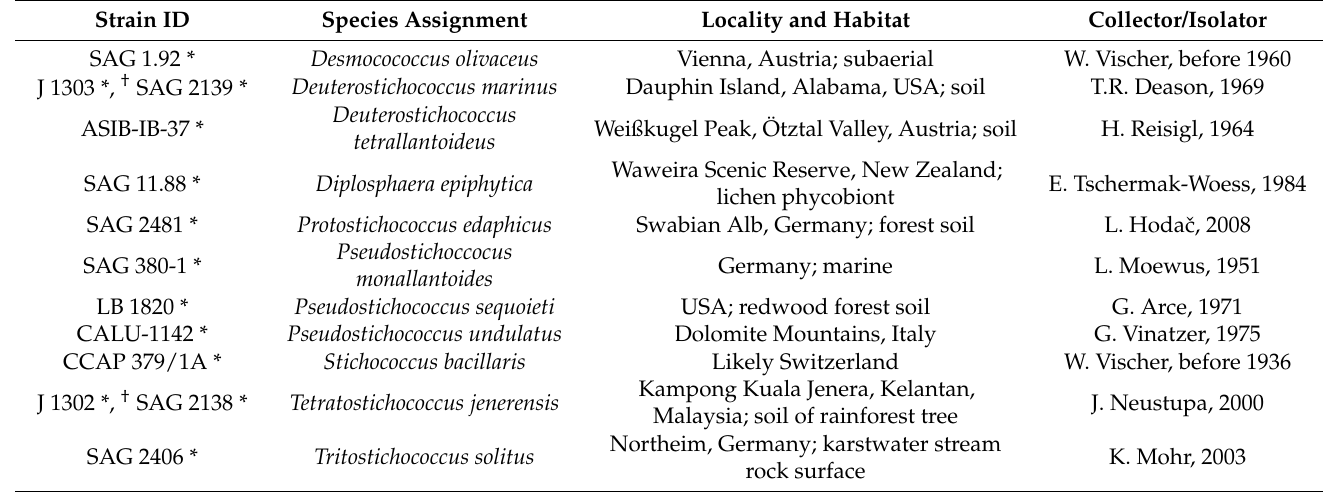
Table 1. The strains used in this study and their culture ID, localities, and collector information. Equivalent strains from different culture collections are marked with a “ † ”; strains marked with “*” are authentic strains. All strains except SAG 1.92 were used in the dehydration and recovery experiment; all strains were used in the salt growth experiment. Strain